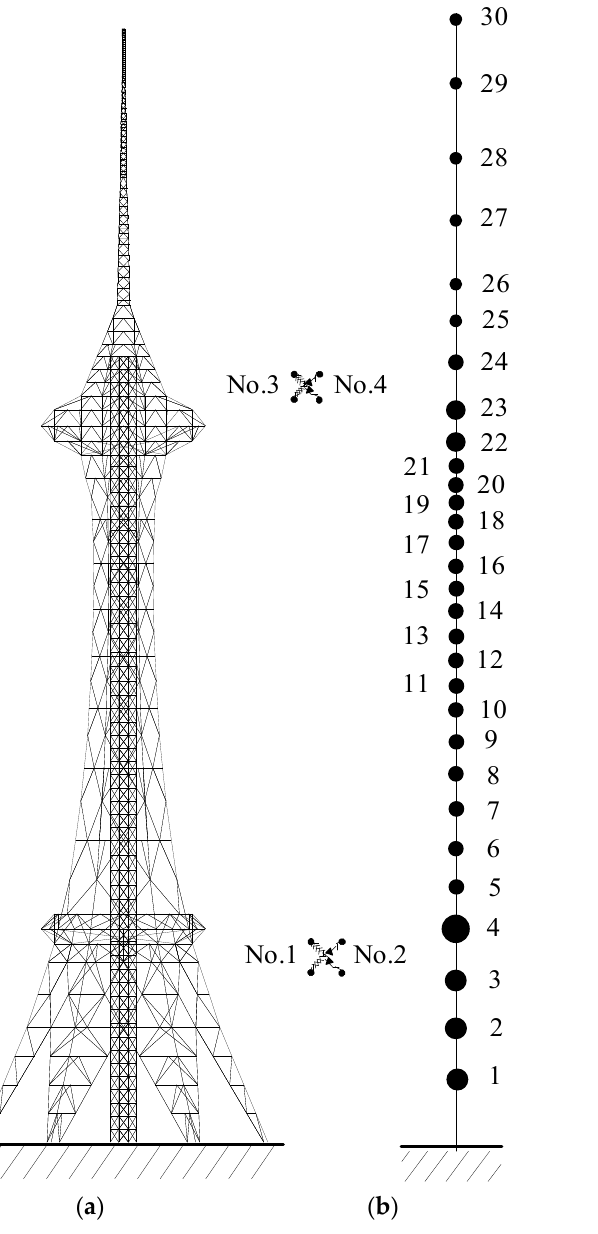
Figure 1. Analytical model of a TV transmission tower. ( a ) 3D FE model; ( b ) 2D dynamic model.